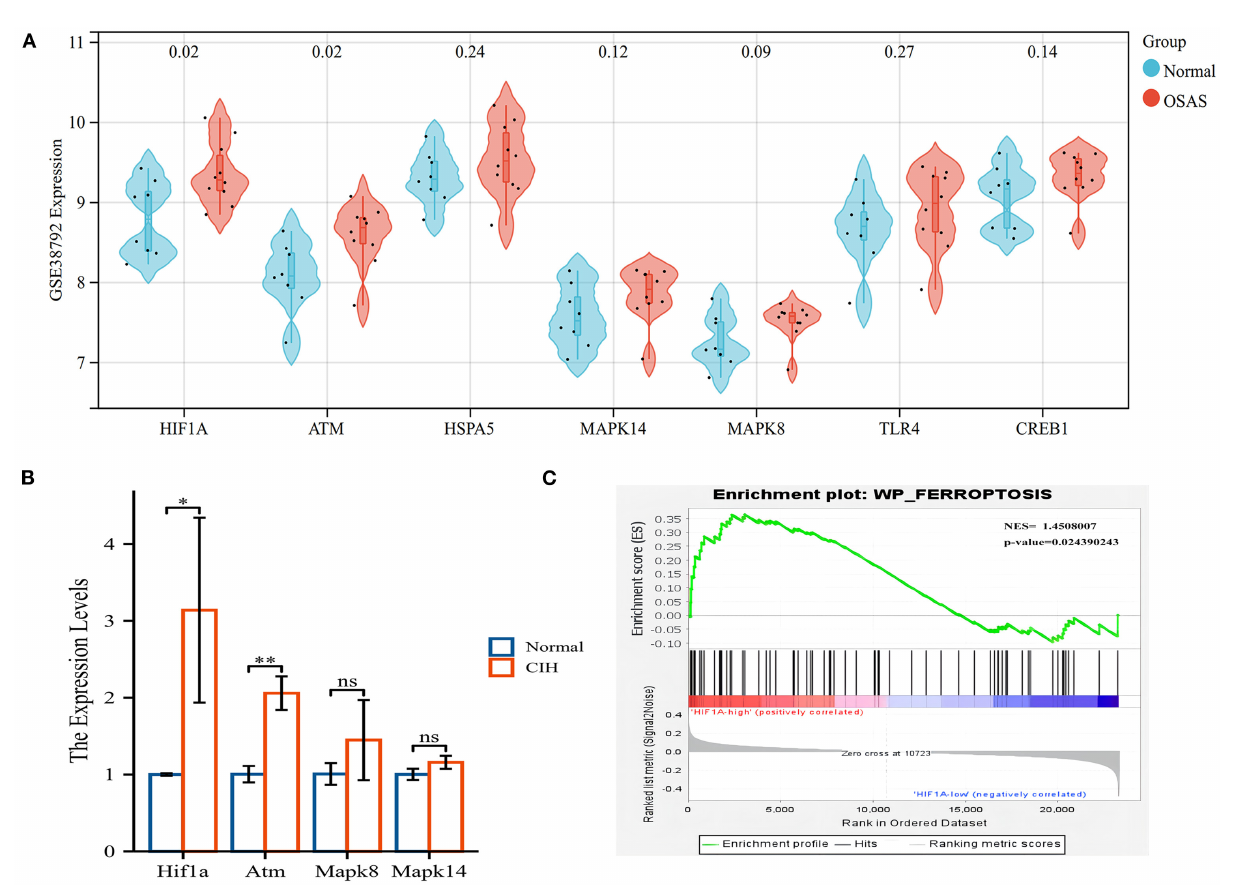
FIGURE6 The hub genes (HIF1A and ATM) were validated in another OSAS dataset and the rats qRT-PCR experiment. (A) The hub genes were imported into the GSE38792 dataset for validation. (B) The mRNA levels of hub genes in the rats of CIH and Normal groups. (C) GSEA analysis of HIF1A expression level, NES = 1.4508007, P = 0.024. * P < 0.05, ** P < 0.01.